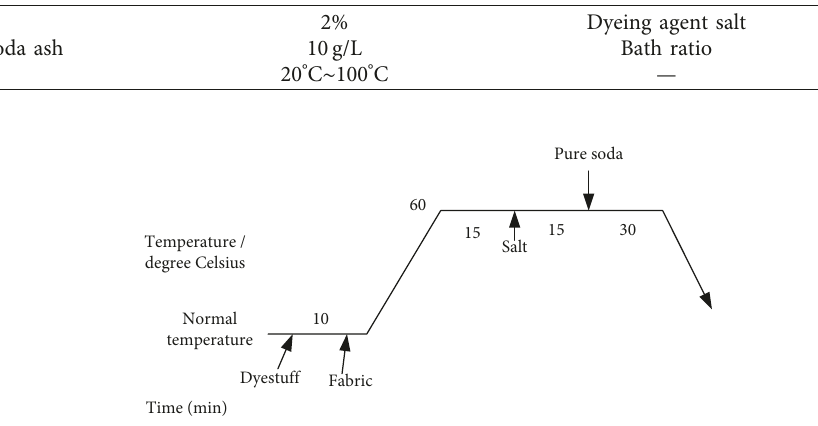
Figure 6: Heating curve of tie-dyeing process.